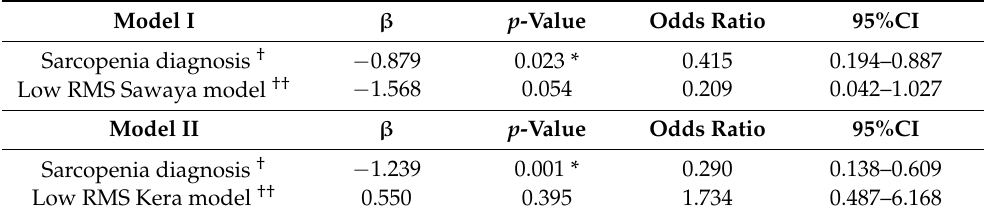
Table 2. Results of a binomial logistic regression analysis to investigate associations between de- creased MEP and baseline assessments of sarcopenia and